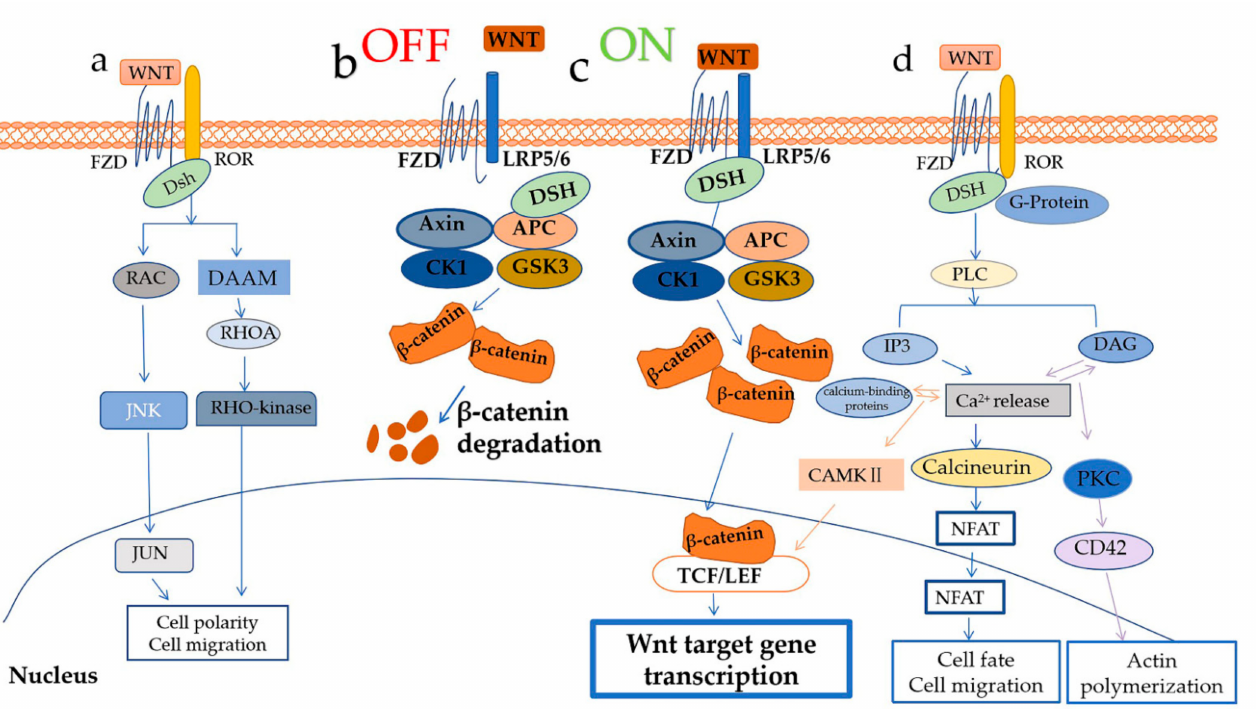
Figure 1. WNT signaling pathways. WNT regulates at least three distinct intracellular signaling pathways: ( a ) The WNT/Planar Cell Polarity (PCP) pathway. ( b , c ) the WNT/ β –catenin pathway: ( b ) the OFF state of the WNT/ β –catenin pathway, absent WNTs stimulation; ( c ) the ON state of WNT/ β –catenin pathway, when the WNT ligands couple to receptors. ( d ) the WNT/Ca 2+ pathway. Please see text for other